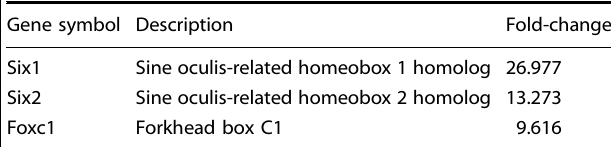
Table 1. Candidates of speci fi c transcription factors for mouse